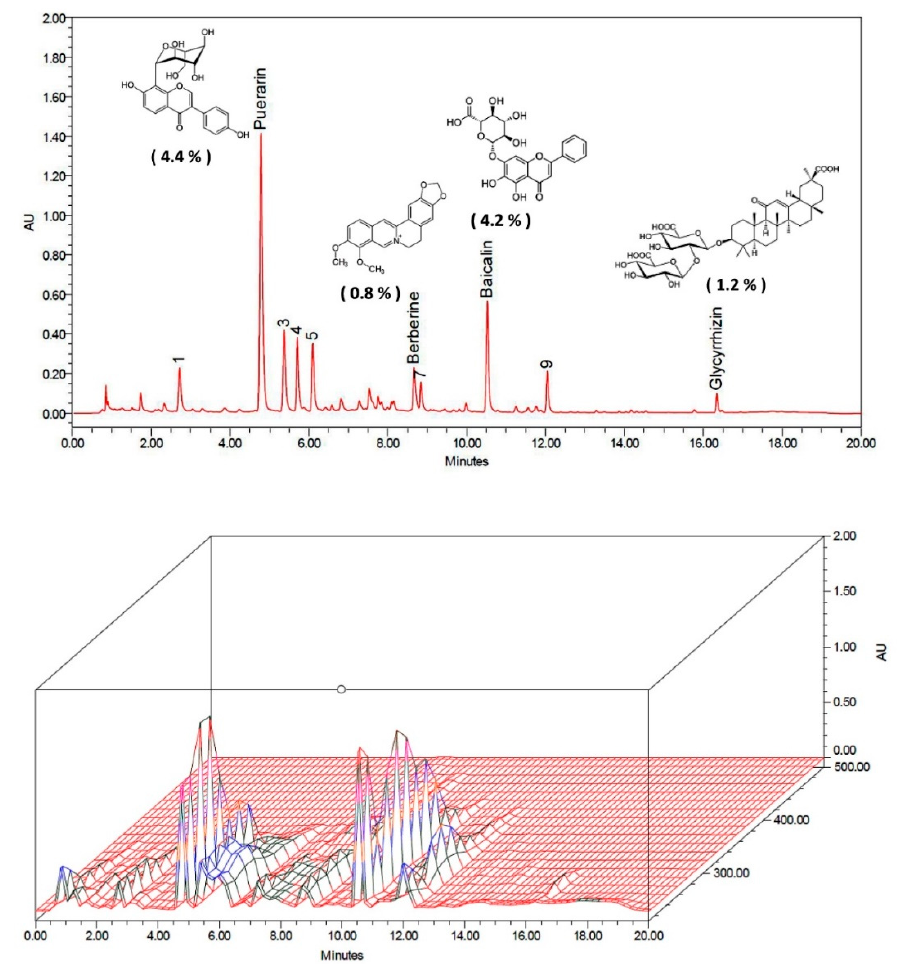
Figure 1. Chromatogram of Ger-Gen-Chyn-Lian-Tang (GGCLT) by high-performance liquid chromatography (HPLC) analysis. The upper panel shows the peaks, compound structure, and ingredient percentages of puerarin, baicalin, berberine, and glycyrrhiza, the four main index components of Puerariae radix, Scutellariae radix, Coptisis rhizoma and Glycyrrhizae radix , respectively. The lower panel shows the fingerprint of the three-dimensional structures of these four main index components, as determined by HPLC analysis.